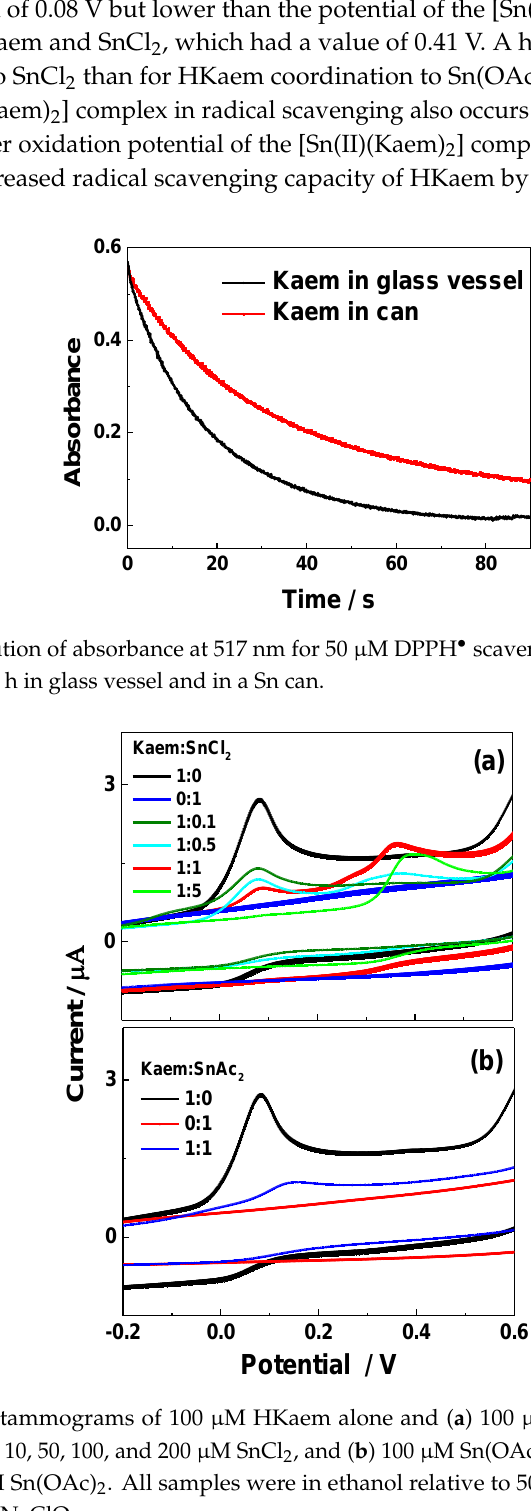
Figure 7. Absorption spectra of 100 µM DPPH • , 100 µM DPPH • plus 100 µM HKaem, 100 µM DPPH • plus 100 µM SnCl 2 /Sn(OAc) 2 , and 100 µM DPPH • plus 100 µM HKaem + 100 µM SnCl 2 /Sn(OAc) 2 . Ethanol was used as the solvent.